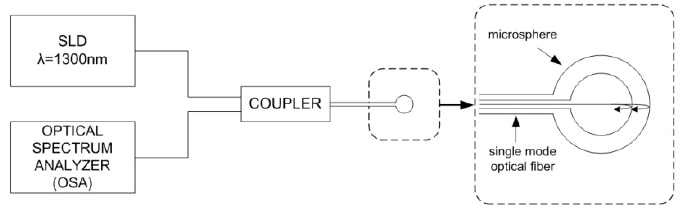
Figure 2. Operating principle of Fabry–Pérot interferometer used for measurements.